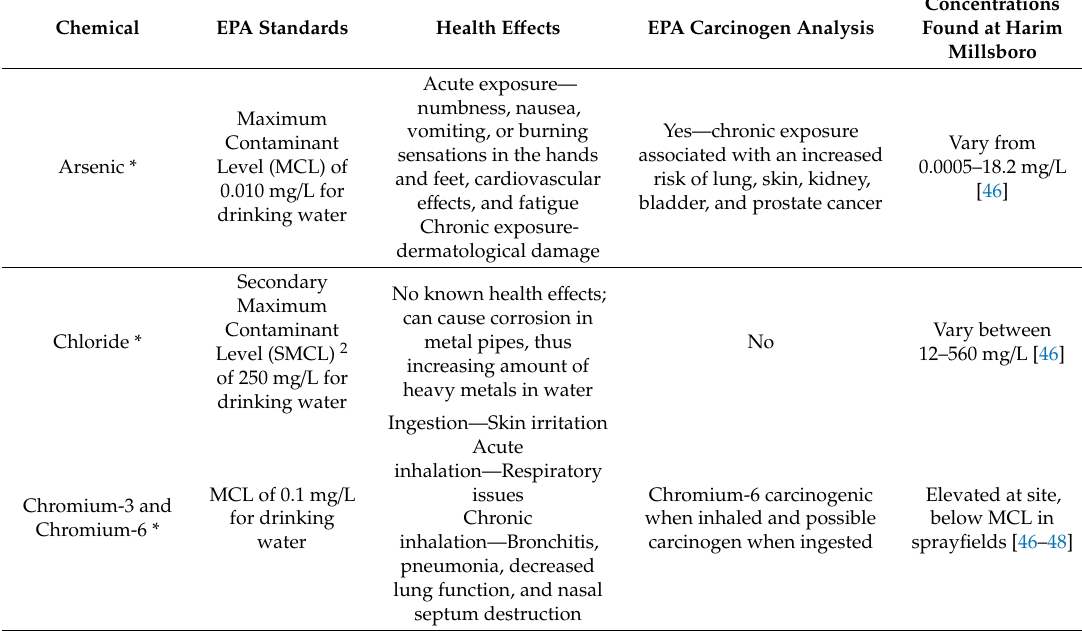
Table 2. Chemical Information of Pollutants at the Harim Millsboro Processing Plant